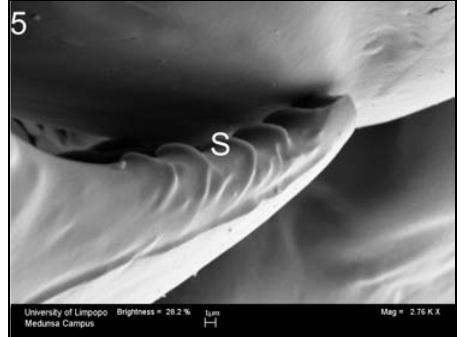
Fig. 5. A high magnification of the oral surface of the right mandible where (s) represents the serrated surface.